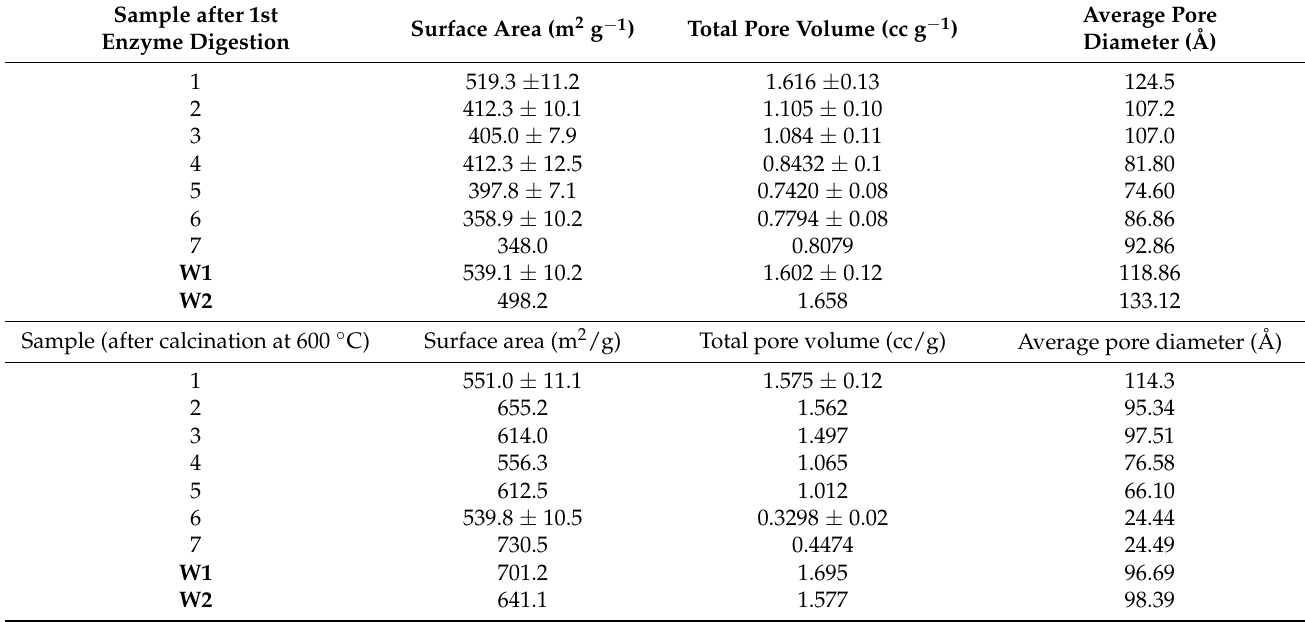
Table 2. Summary of surface area and total pore volume measured by N 2 absorption after 1st enzyme digestion and after further calcination at 600 ◦